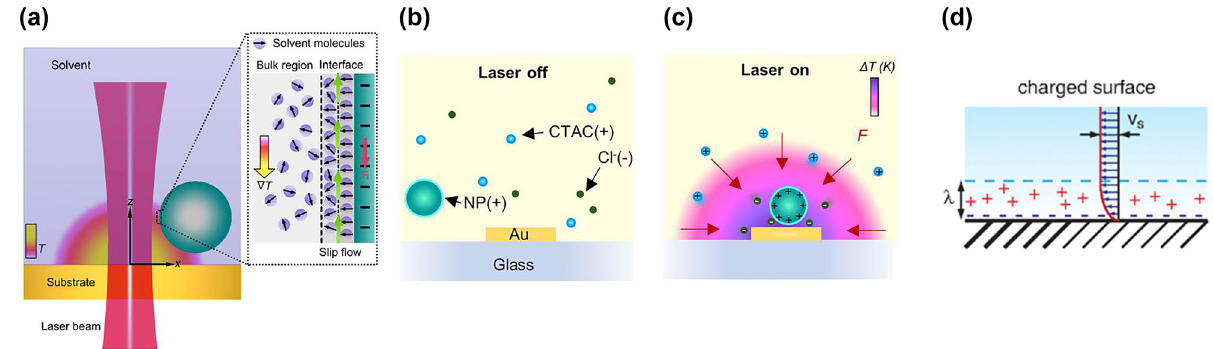
Figure 3: Optothermophoretic